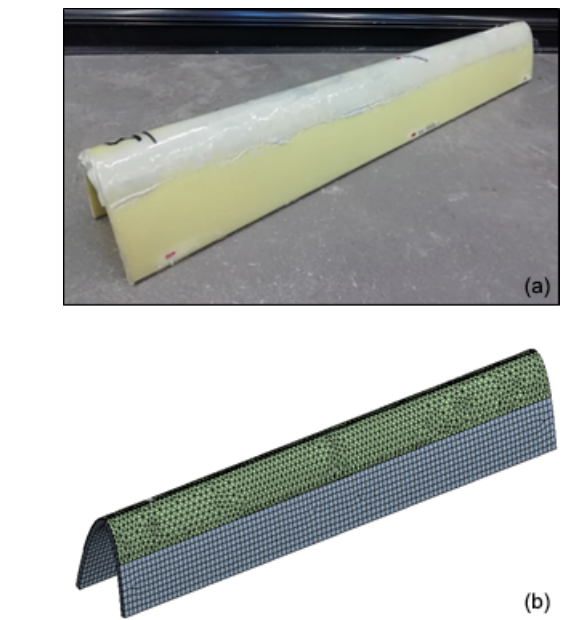
Figure 6. Leading edge demonstrator used for the validation study, showing (a) the physical model used for the experimental trials and (b) the meshed geometry used in the numerical FEA model.